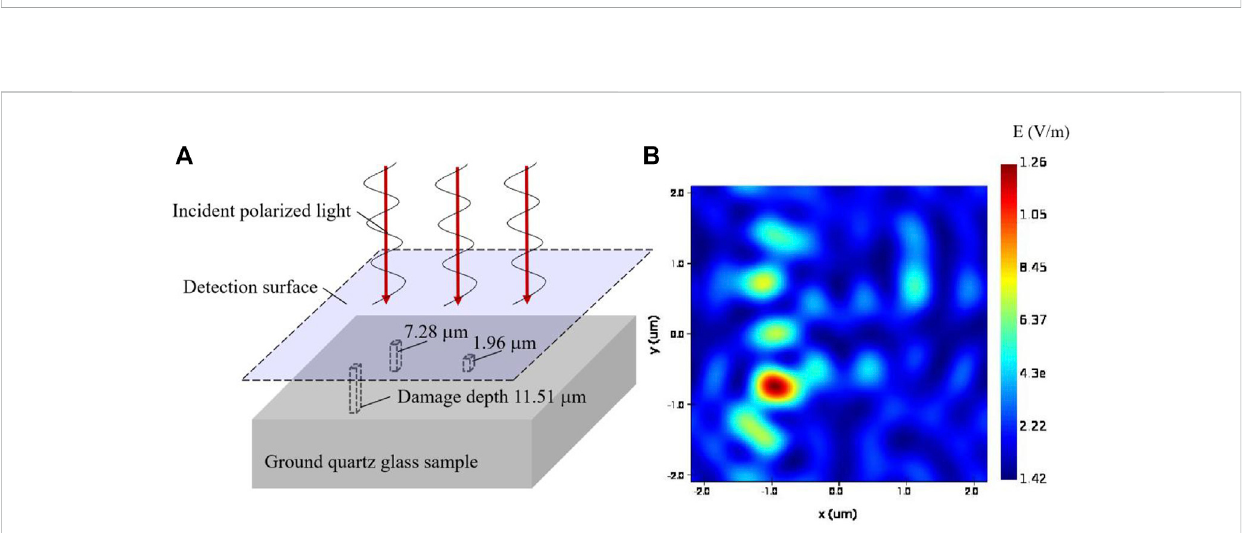
FIGURE 5 (A) FDTD simulation model of laser scattering, (B) distribution of electric fi eld intensity of FDTD